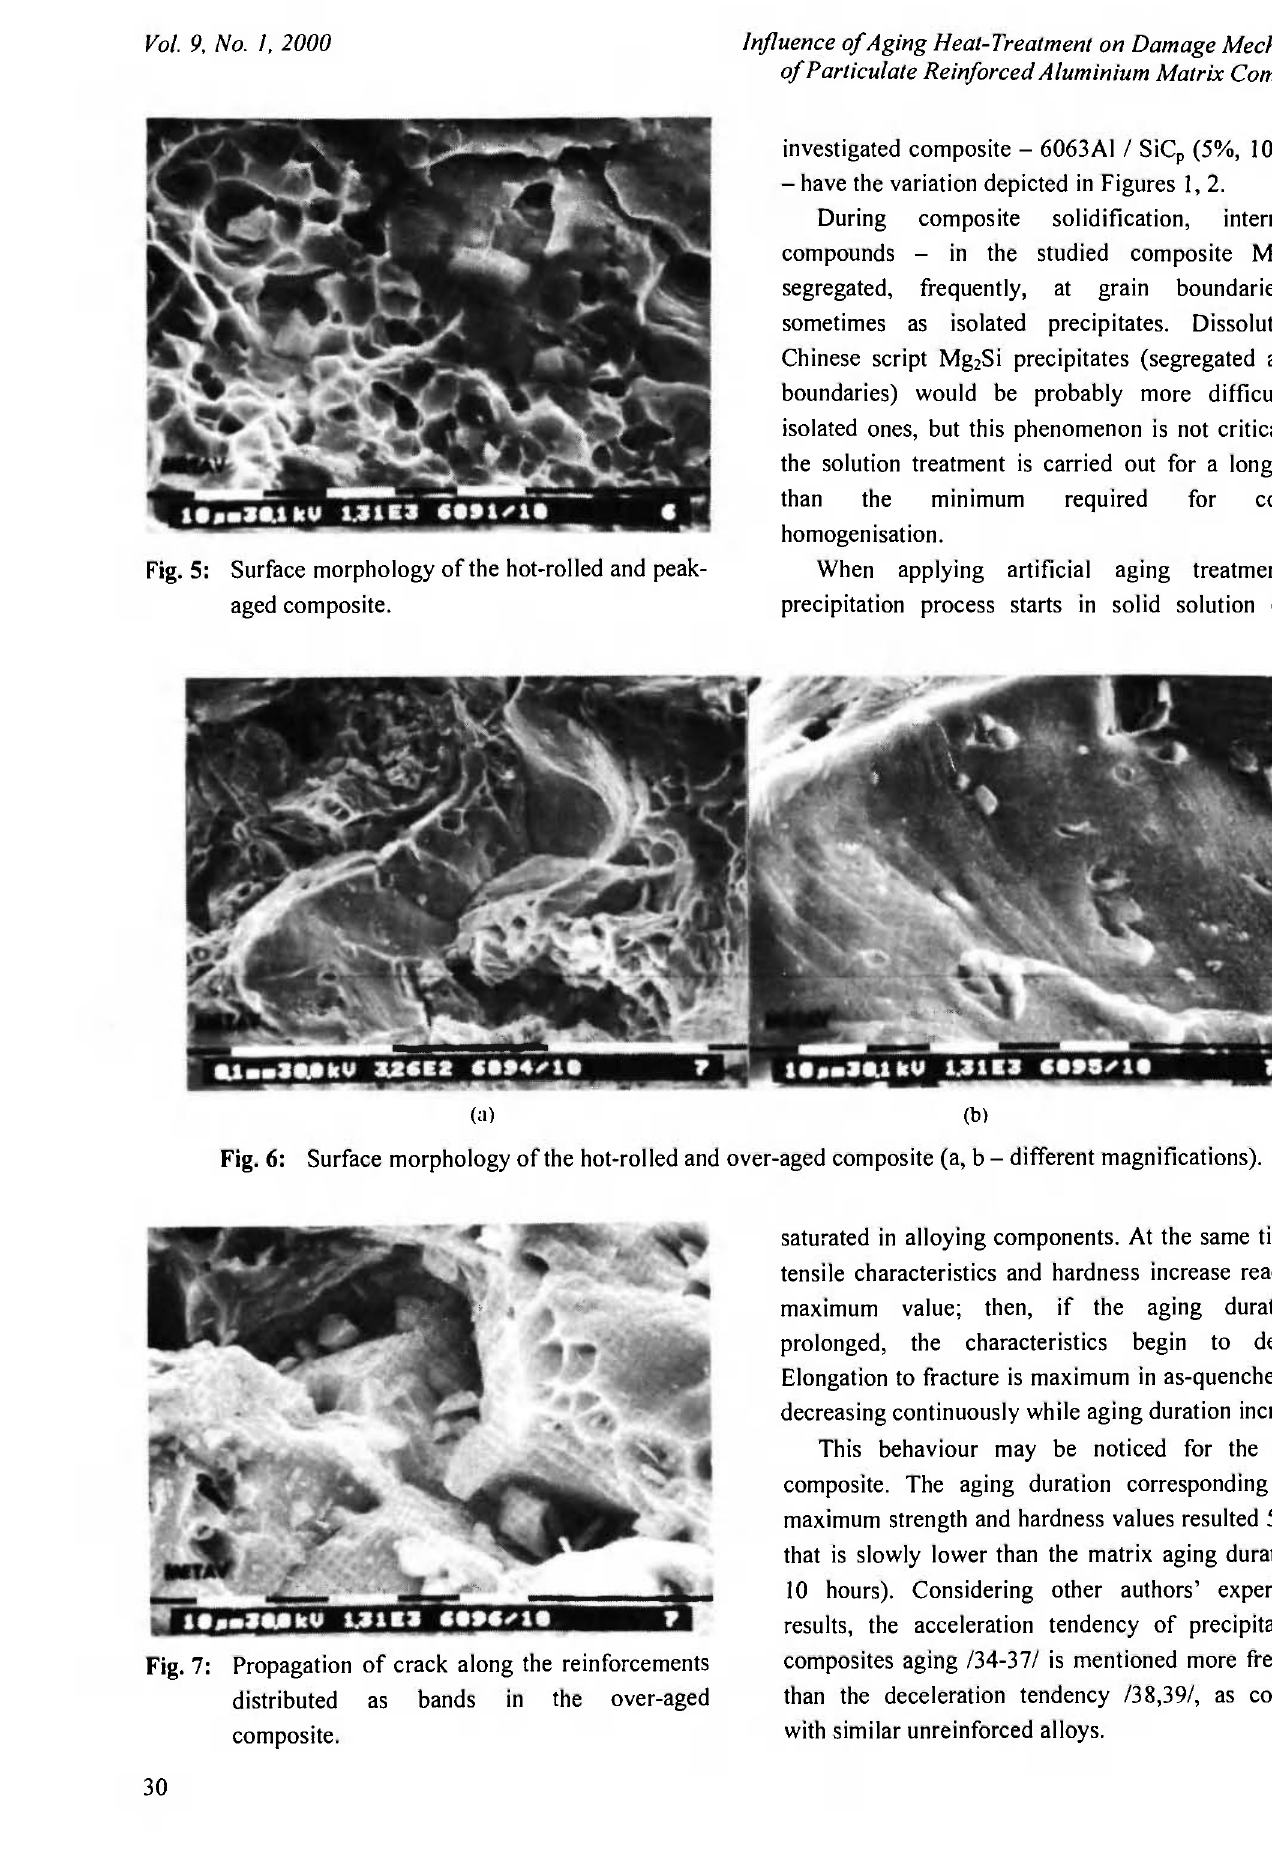
Fig. 7: Propagation of crack along the reinforcements distributed as